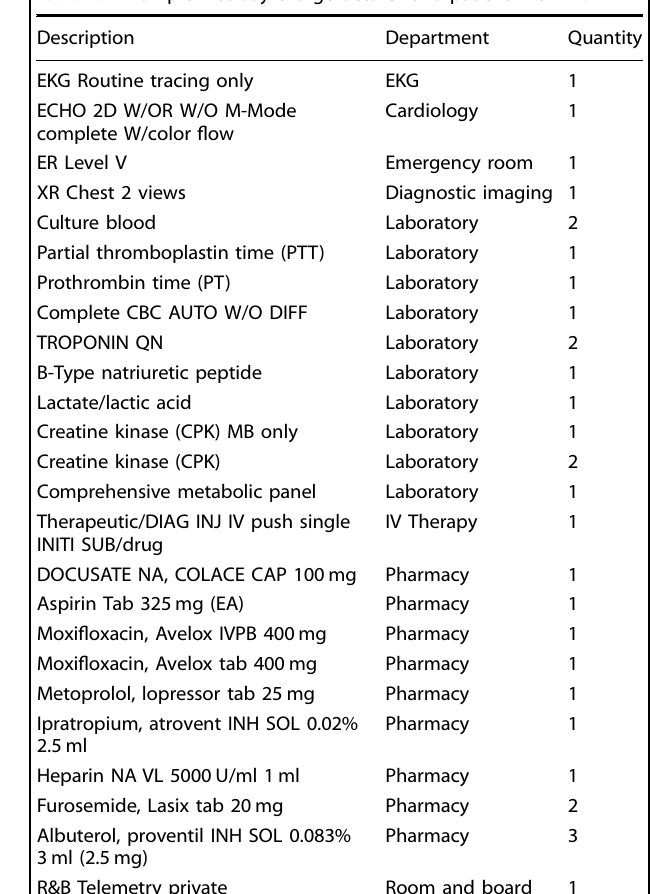
Table 1. Example fi rst day charge details for a patient with